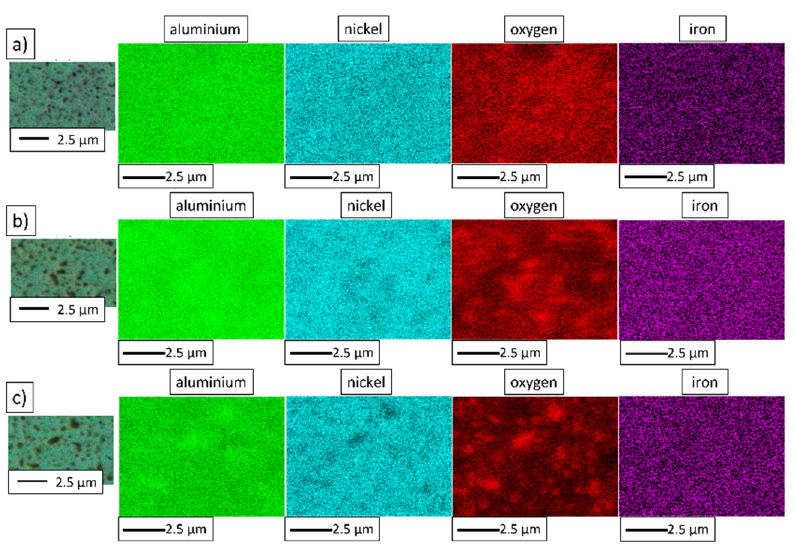
Figure 13. The NiAl-10%Al 2 O 3 samples’ elemental distribution maps after sintering by PPS at different temperatures: ( a ) 1200 °C; ( b ) 1300 °C; ( c ) 1400 °C.